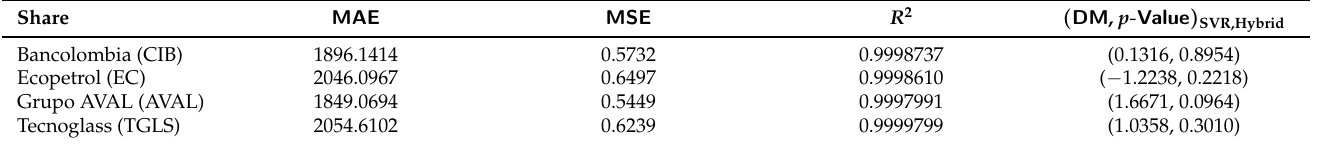
Figure 6. Real vs. SVR adjustment for the cumulative returns of Bancolombia, Ecopetrol, Grupo AVAL, and Tecnoglass. The real time series is represented by the share symbol and its prediction with the model name in the legend. Table 5. MAE, MSE , and R 2 for the daily returns forecast using the SVR model. The Diebold–Mariano test was used for the prediction pair ( DM , p -value ) SVR,Hybrid . MAE and MSE columns are multiplied by 10 − 7